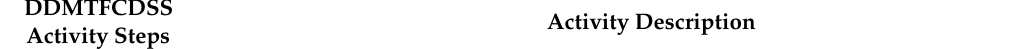
Table 3. First design steps for the framework for the development of data-driven Mamdani-type CDSS. Activity Steps